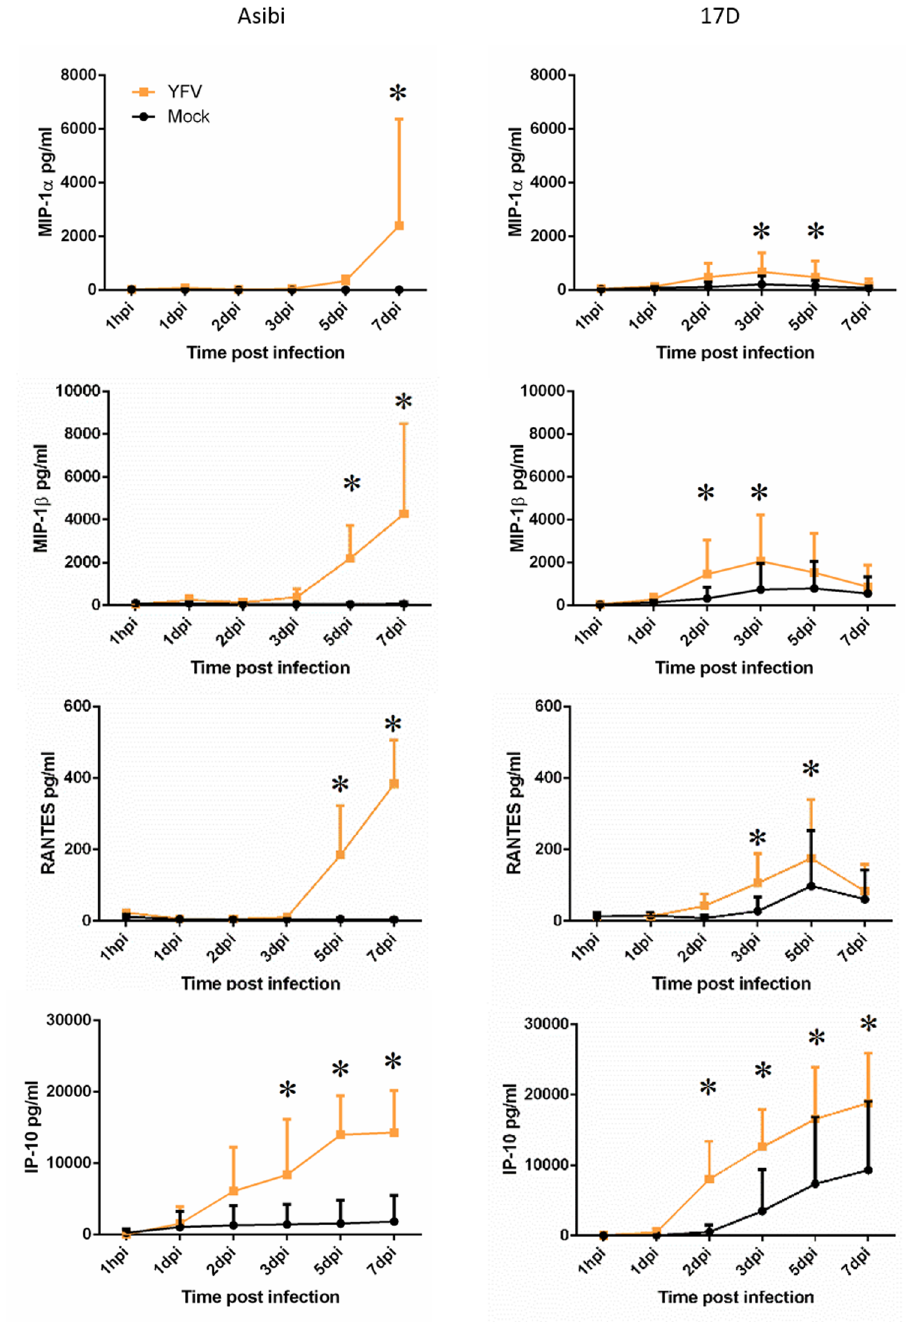
Fig 4. Chemokine response in human MDM. Chemokine response in human MDM infected with either wild-type Asibi virus or the vaccine strain 17D virus (yellow) in relation to mock (black) infected cells. All data points represent triplicate biological replicates. ( * ) indicates points of significant (p < 0.05) difference between virus and mock infected cells. Repeated measures ANOVA run in SAS was used to determine statistical